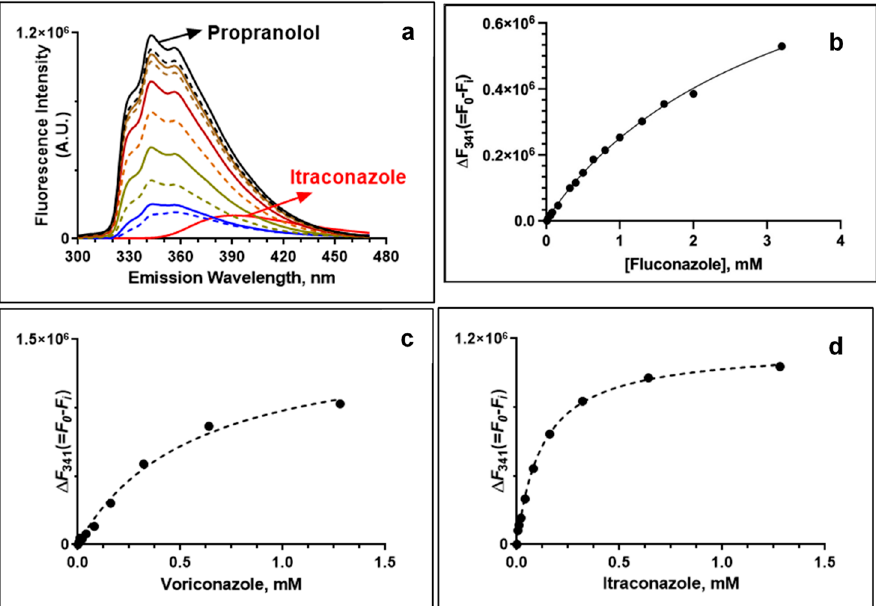
Figure 2 . Interactions between propranolol and azole drugs monitored by fl uorescence spectros- Figure 2. Interactions between propranolol and azole drugs monitored by fluorescence spectroscopy. copy. ( a ) Fluorescence scan of propranolol upon addition of increasing concentrations of itracona- zole. Fluorescence titration of azole drugs showing the change in fl uorescence intensity (at 341 nm) of propranolol: ( b ) propranolol and fl uconazole; ( c ) propranolol and voriconazole (Vor) and ( d ) propranolol and itraconazole (I tz ).